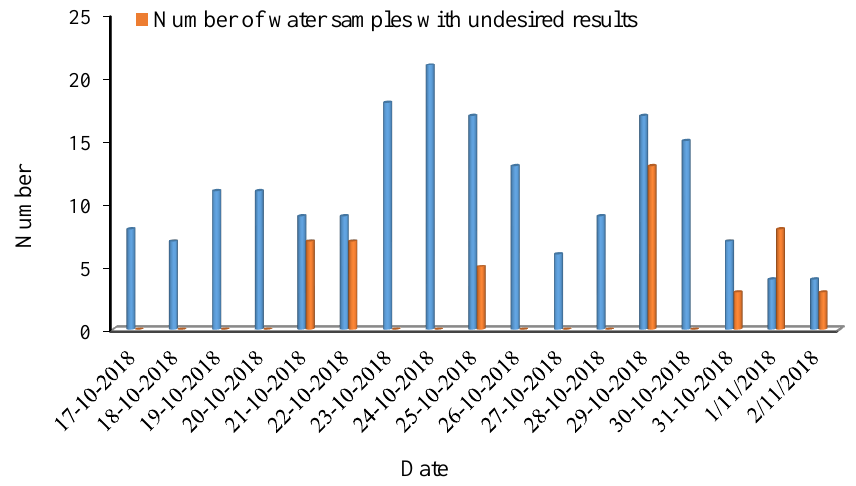
Fig. 7. Number of water samples and their results